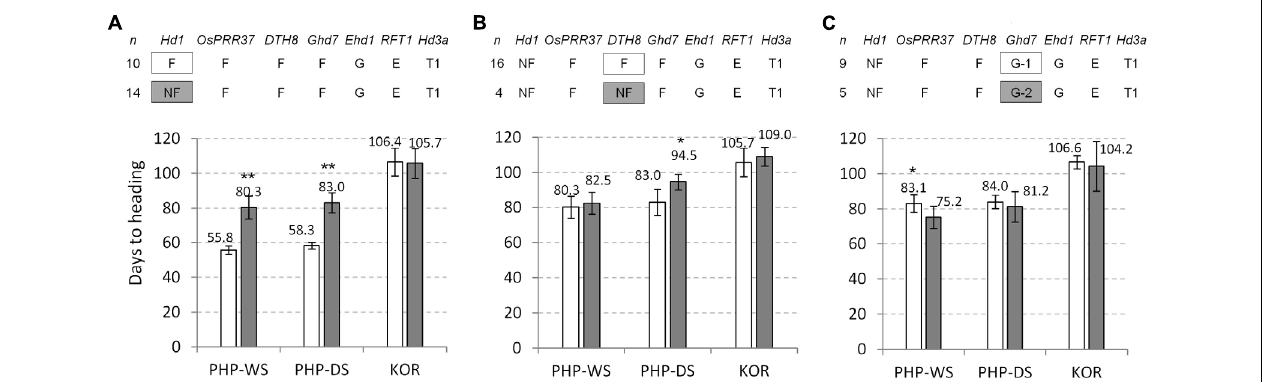
FIGURE 4 | Genetic effects of the major flowering genes on flowering time in three different field conditions. Allele types of each flowering gene and the number of samples are presented on the top panel. (A) Genetic effect of Hd1 . (B) Genetic effect of DTH8 . (C) Comparison of the genetic effects between Ghd7-1 (G-1) and Ghd7-2 (G-2) alleles. A significant difference between two groups was calculated based on Student’s t -test ( ∗ α = 0.05 and ∗∗ α = 0.01). PHP, Philippines; KOR, Korea. DS, dry season; WS, wet season.